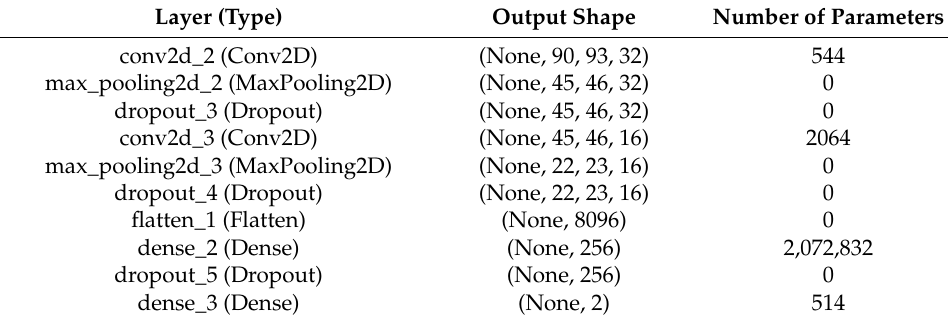
Table 2. Model of the network used in Experiment